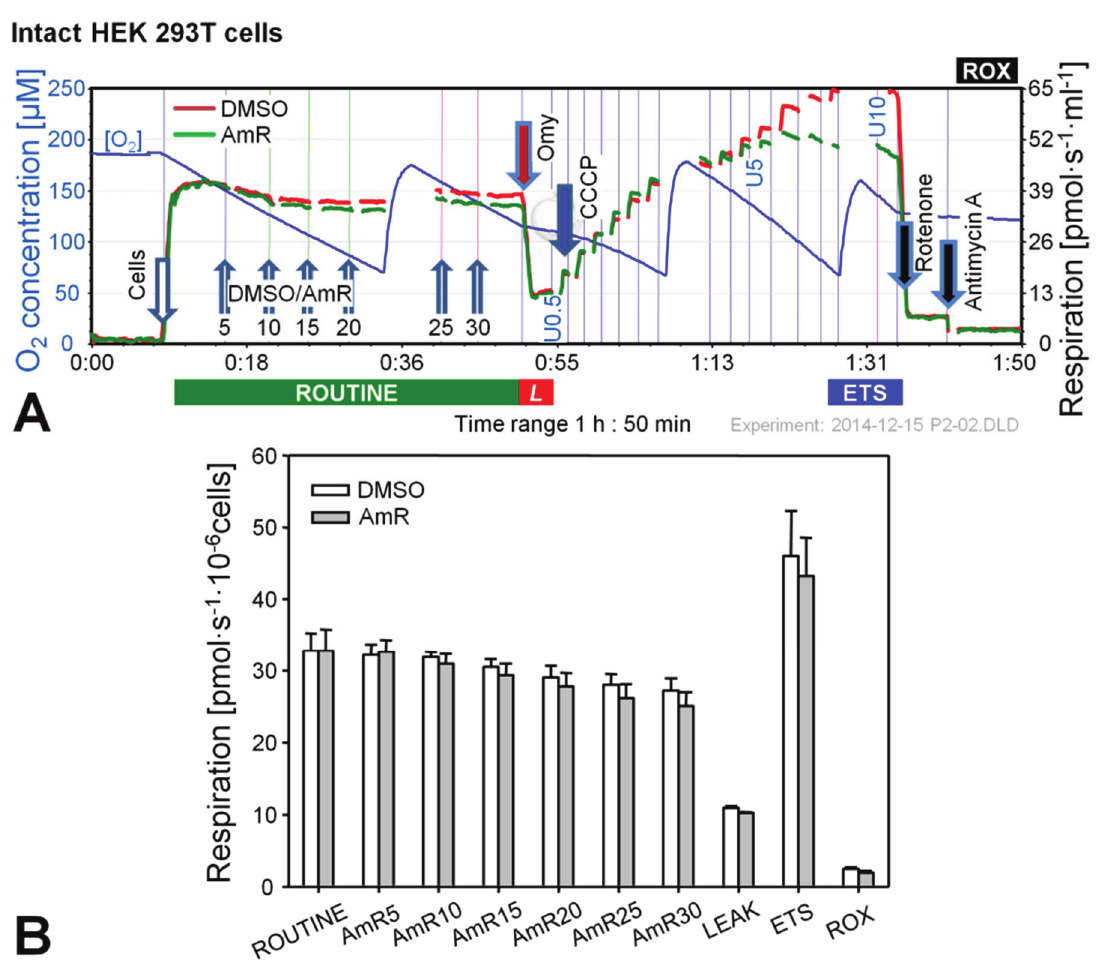
Figure 1. Effect of Amplex UltraRed (AmR) on respiration of intact HEK 293T cells. ( A ) Representative respiratory experiment with AmR or carrier DMSO titrated in the ROUTINE state. Oxygen concentration (blue plot; left Y -axis [μM]) is shown for one chamber, whereas oxygen fluxes per chamber volume (red and green plots; right Y -axis [pmol·s (cid:2)1 ·mL (cid:2)1 ]) are depicted for both O2k-chambers operated simultaneously. The horizontal bar denotes the respiratory states, ROUTINE; LEAK state, L ; progressively uncoupled states in which ETS capacity is reached at maximum flux; and residual oxygen consumption, ROX. Numbers indicate final AmR concentrations [μM]; U0.5, U5 and U10 indicate final uncoupler concentrations [μM], added in 0.5 μM steps between 0.5 and 5 μM and 1 μM steps between 5 and 10 μM. Discontinuities of the plots are due to removal of sections with artifacts arising from titrations or re-oxygenations; ( B ) Oxygen flow expressed as respiration per million cells [pmol·s (cid:2)1 ·10 (cid:2)6 cells], mean ± SE of N = 3–5 independent cultures, each measured in duplicate ( n =